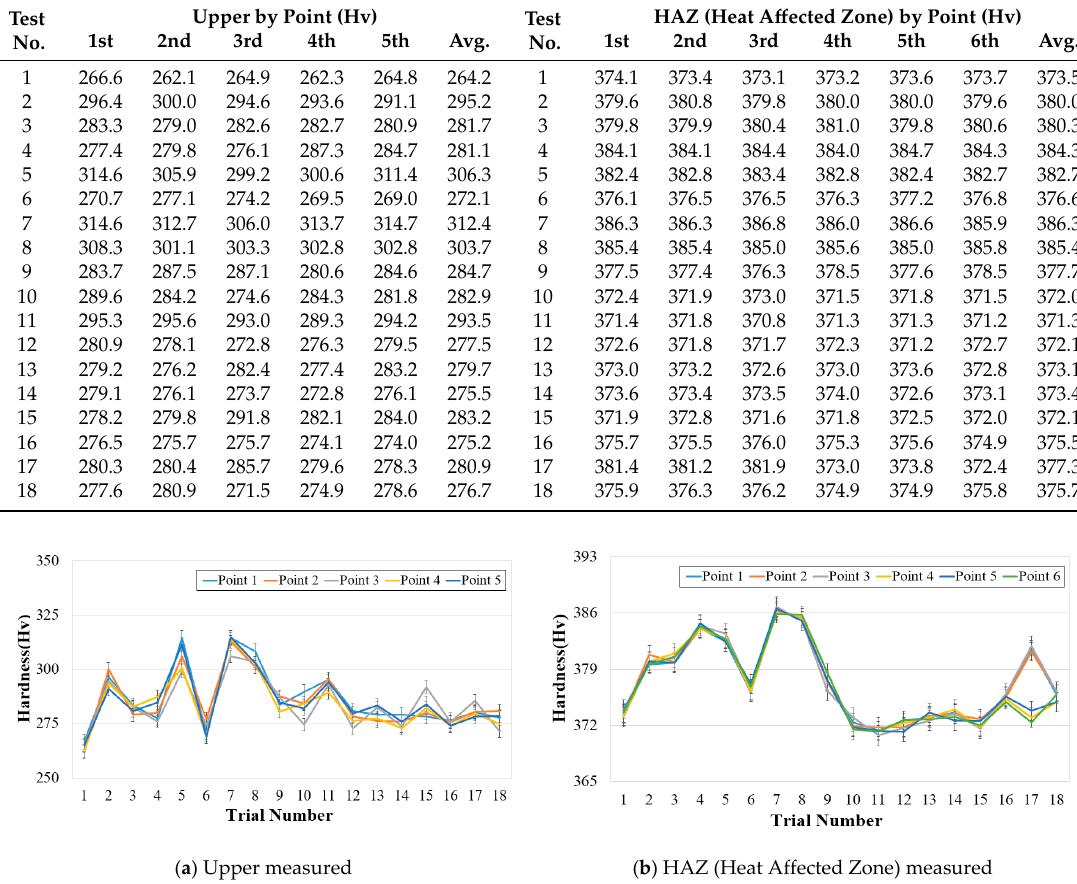
Figure 5. Hardness distributions according to measured position.